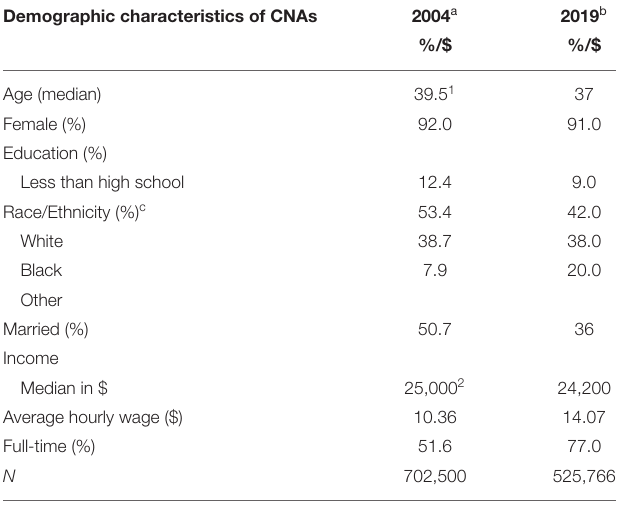
TABLE 3 | Kendall’s ( τ b ) correlations between state training requirements for certified nursing assistants (CNAs) state average COVID-19 infection and